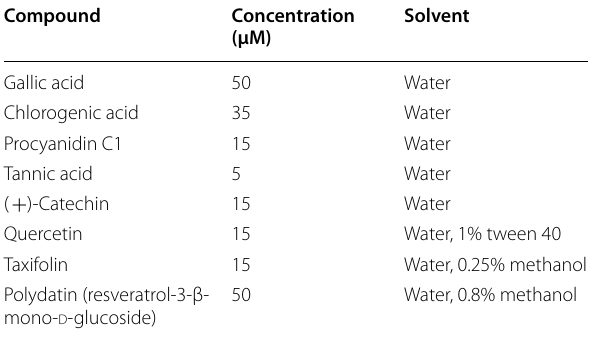
Table 1 List of commercially available phenolic compounds tested in this